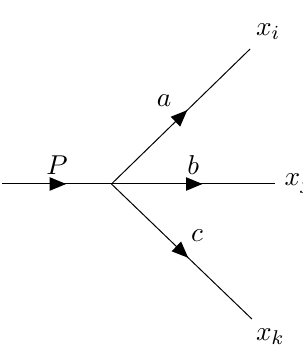
Figure 2 . The remainder function R abc → P contains the parts of the triple collinear splitting function that are not contained in the strongly-ordered, iterated